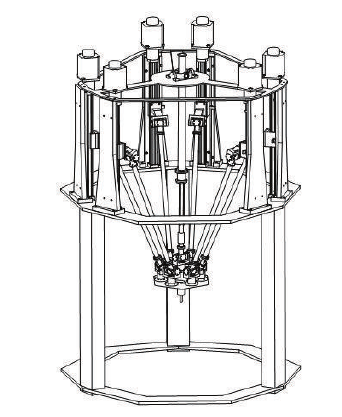
Figure 1: 6PUS-UPU parallel